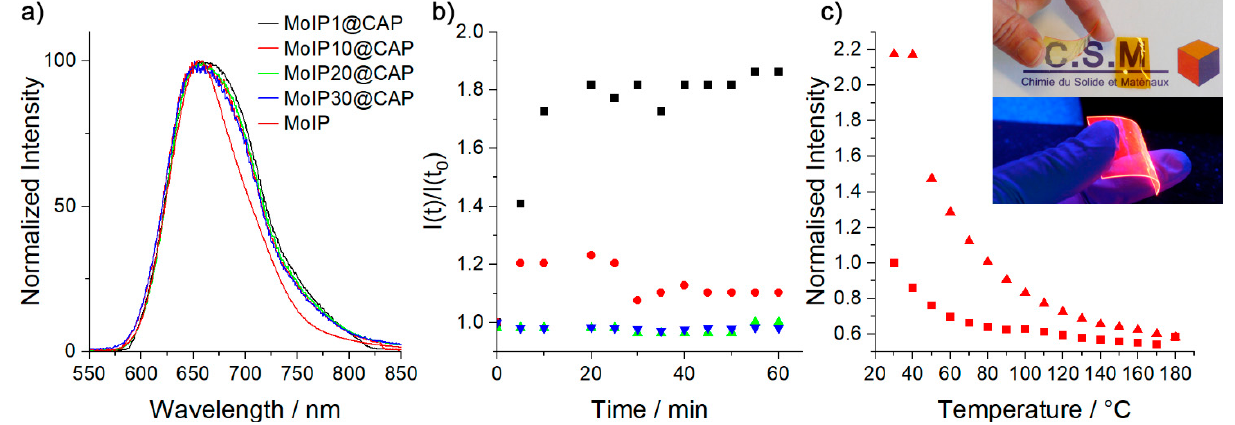
Figure 5. ( a ) Emission spectra of MoIP1@CAP (black), MoIP10@CAP (red), MoIP20@CAP (green), MoIP30@CAP (blue), and MoIP cluster complex (dark red). ( b ) Photostability under constant irradiation of MoIP1@CAP (black square), MoIP10@CAP (red circle), MoIP20@CAP (green triangle), and MoIP30@CAP (blue inverted triangle). ( c ) Photostability studies with temperature for MoIP10@CAP (square: on first heating, triangle: on cooling); inset: MoIP1@CAP and MoIP10@CAP under natural light (top) and MoIP1@CAP under UV-A irradiation (bottom).